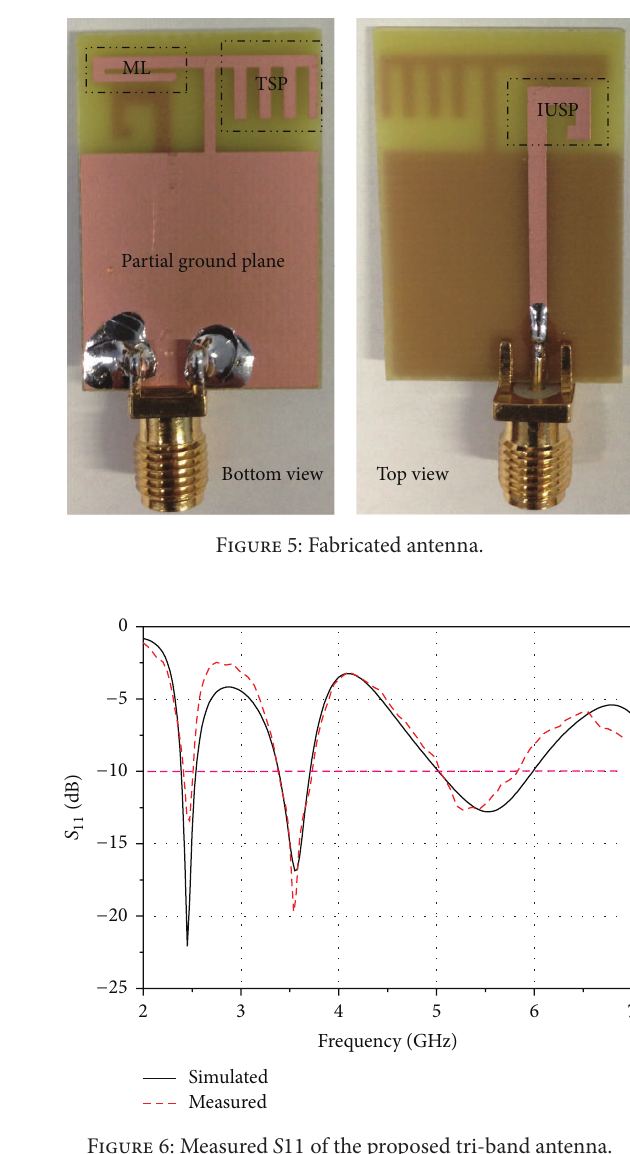
Figure 4: Effects of the parameter 𝑊6 on the return loss.